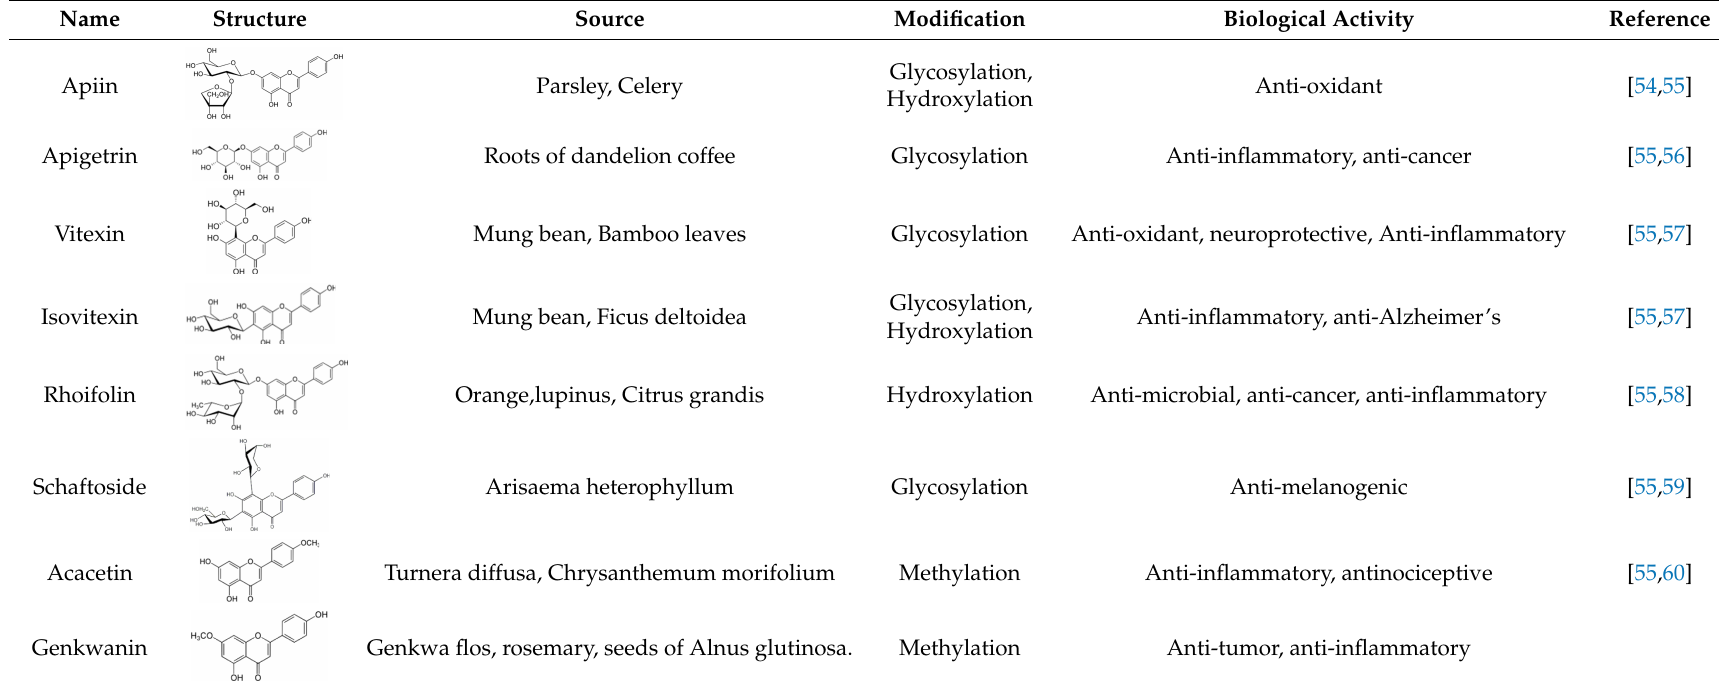
Table 2. Naturally occurring apigenin